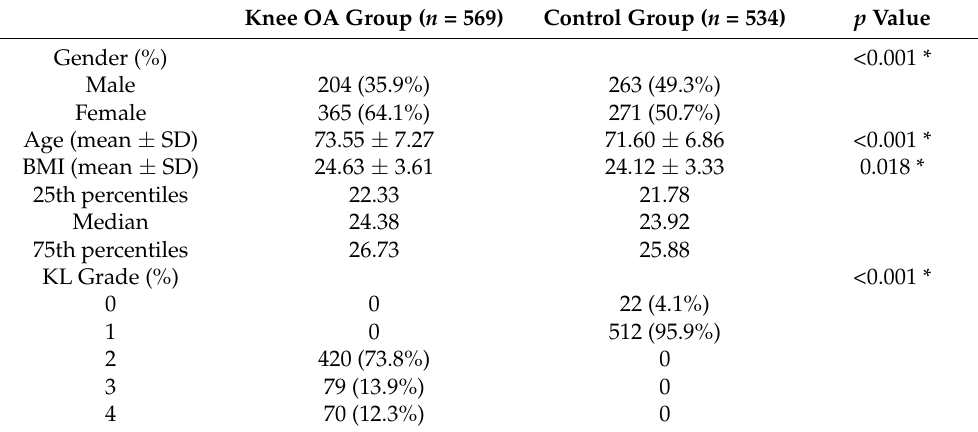
Table 1. Baseline demographic characteristics of the study subjects.